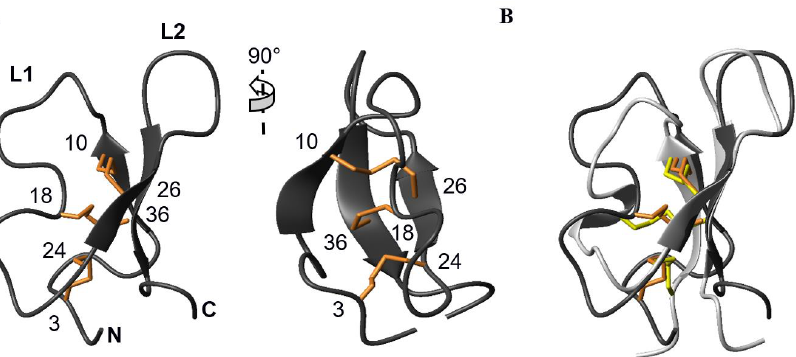
Figure 3. ( A ) Ribbon representation of AG41 lowest energy structure illustrating the inhibitory cysteine-knot fold with bridge 18–36 going through the macrocycle formed by disulfides 3–24 and 10–26 and the interconnecting backbone. ( B ) Superposition of ribbon representations of AG41 (dark grey, orange disulfide bridges) and PA1b (light grey, yellow disulfide connectivities) in the same orientation as in ( A ), fitted on the strands 2 and 3 that are involved in the β -hairpin. Not surprisingly given the high sequence similarity in this region, AG41 and PA1b hairpin loop backbones superimpose quite well (RMS deviation calculated over the β - strands residues 21 – 24,30 – 33 for PA1b/25 – 28,34 – 37 for AG41 = 0,37 0,03 Å ) (Figure 3b). A reverse γ -turn is observed between Leu27 and Trp29 in AG41, stabilized by the canon- ical C=O(27) — NH(29) hydrogen bond found on the 10 selected structures, as was ob- ser ved between Ile23 and Val25 in PA1b. However, the following β -turns involving Gly30-Leu31-Phe32-Phe33 in AG41 and Gly26-Leu27-Val28-Ile29 in PA1b, respectively, adopt slightly different orientations, in line with the facing loop L 1 . The N-terminal parts of the two peptides adopt different conformations due to the presence of three additional residues between the first couple of cysteines (Cys3 and Cys10) in AG41, compared to PA1b (Figure 1). The structure being packed by the disulfides, incorporation of these extra residues is accommodated by a shortening of strand 1 in AG41 (Ala8-Val9) with respect to that in PA1b (Asn4-Gly5-Val6- Cys7), and by the formation of a type G1 β -bulge (Gly7, Ala8 opposite Cys36), is classically associated with a type II tight turn between Asn5 and Ala8. At the end of strand 1 and the beginning of loop L1, the VCSPFE pattern of AG41 on its own superimposes quite well with that of PA1b, whereas the second half of loop L 1 , between the third and fourth cysteines, does not. It is one-residue longer in AG41 (Cys18- Gly19-Asn20-Val21-Lys22-Asp23-Cys24) than in PA1b (Cys15-Gly16-Thr17-Ser18- Ala19Cys20). Furthermore, in AG41, loop L1 remains nearly flat, forming a plane with the β -hairpin strand 2, whereas in PA1b, a double-proline motif participates in a 3 10 helix turn that curves loop L1 in a direction perpendicular to that of strand 2. Hence, the directions of the S-S bonds linking Cys15 and Cys32 in PA1b, and Cys18 and Cys36 in AG41, respec- tively, are not the same, whereas the other two disulfides superimpose roughly. 3.2. Structural Comparison Revealed the Potential Key Residues in the Activity of AG41 To extend our comparison between AG41 and PA1b, we calculated the electrostatic and lipophilic potentials at the molecular surfaces of the proteins. Although both proteins share the same global charge (+1), AG41 counts three positively charged residues instead of two, and two negatively charged residues. Analysis of the electrostatic potentials at the surface of AG41 shows that the positive charges are more spread out at the surface of the molecule than in PA1b (Figure 4). They define two positive patches. The first one, rather extended, is formed by the N-terminus and the two lysine residues (Lys22 and Lys16). The second one surrounds Arg25 side chain and appears smaller and weaker than in PA1b due to the loss of the facing arginine on strand 3 of the β -sheet (in AG41, Ile37 replaces